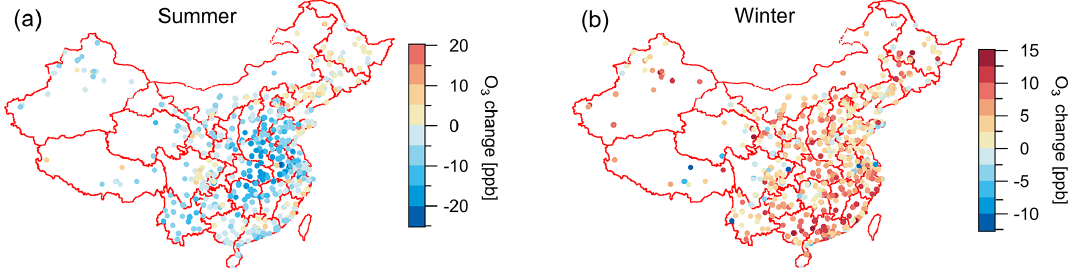
Figure 6. The change in seasonal averages of MDA8 O 3 from 2019 to 2020 in China during summer (a) and winter (b) .